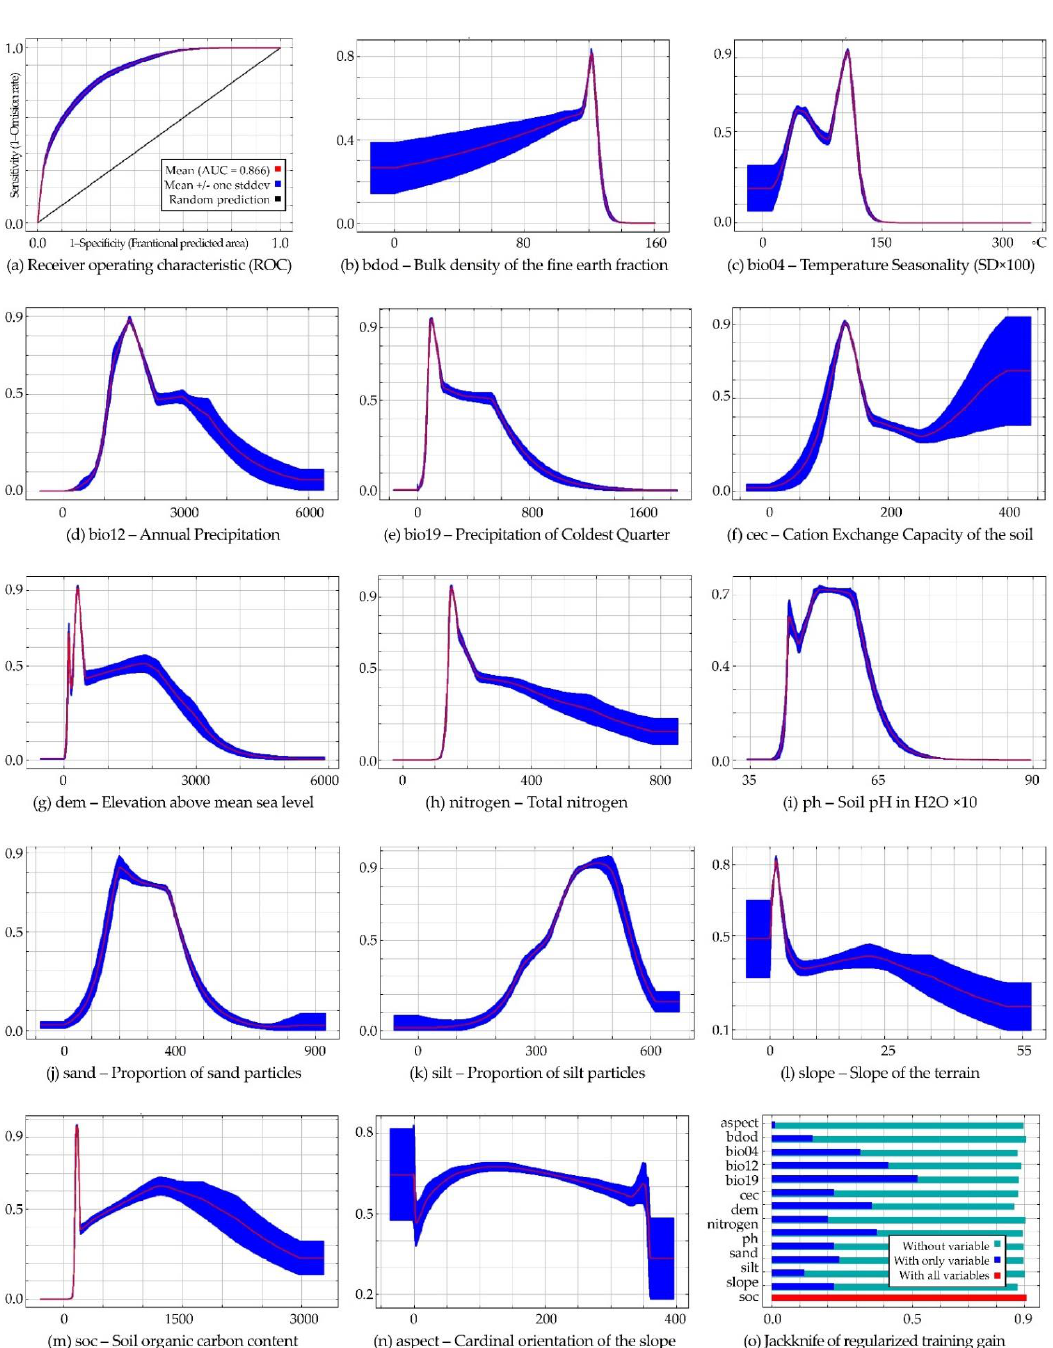
Figure 3. Model performance based on the area under the curve (AUC) ( a ), mean response curves of the 100 replicated MaxEnt runs (red) and standard deviation (blue), showing the relationships between environmental variables and the probability of the presence of the Cedrela ( b – n ), and Jackknife test of environmental variables importance to MaxEnt model of the Cedrela ( o ).